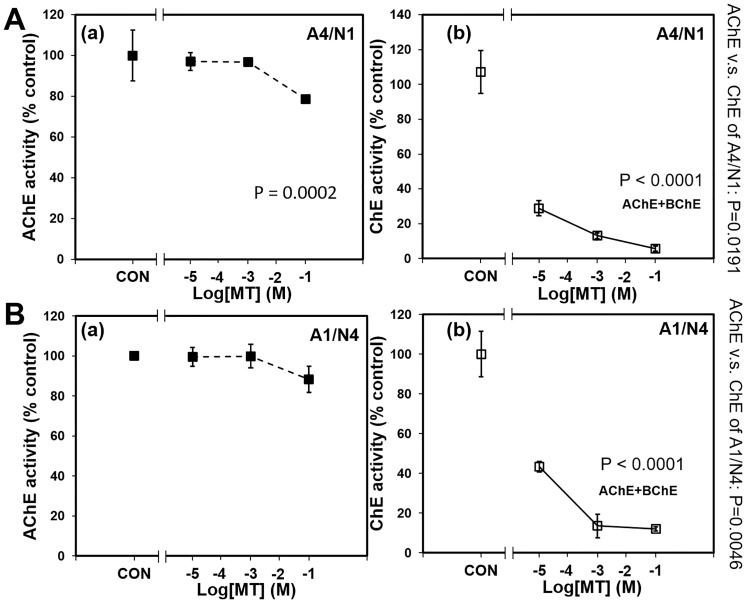
AChE and total ChE activity of brain tissue constructs following acute MT exposure.(A) A4/N1, (B) A1/N4, (a) AChE activity, and (b) Total ChE activity. AChE and total ChE activity for A4/N1 and A1/N4 groups decreased significantly with increase of the MT concentration (One-way ANOVA, P = 0.0002 for A(a), P< 0.0001 for A(b) and B(b)). The decrease comparison between AChE and total ChE activity from Log [20] concentration = -5 to -1 was analyzed with paired t-test (P = 0.0191 when comparing AChE A(a) with ChE of A4/N1 A(b), P = 0.0046 when comparing AChE B(a) with ChE of A1/N4 B(b)).